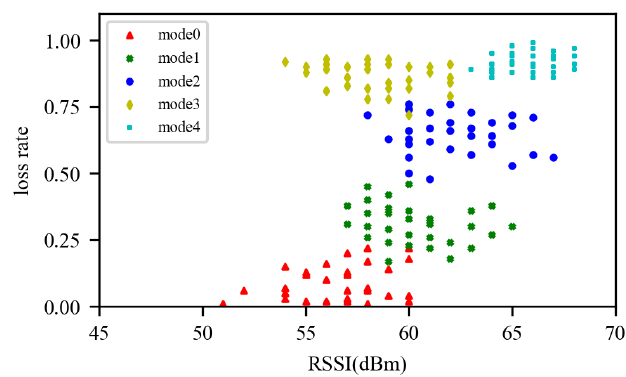
Figure 7. Optimal rate